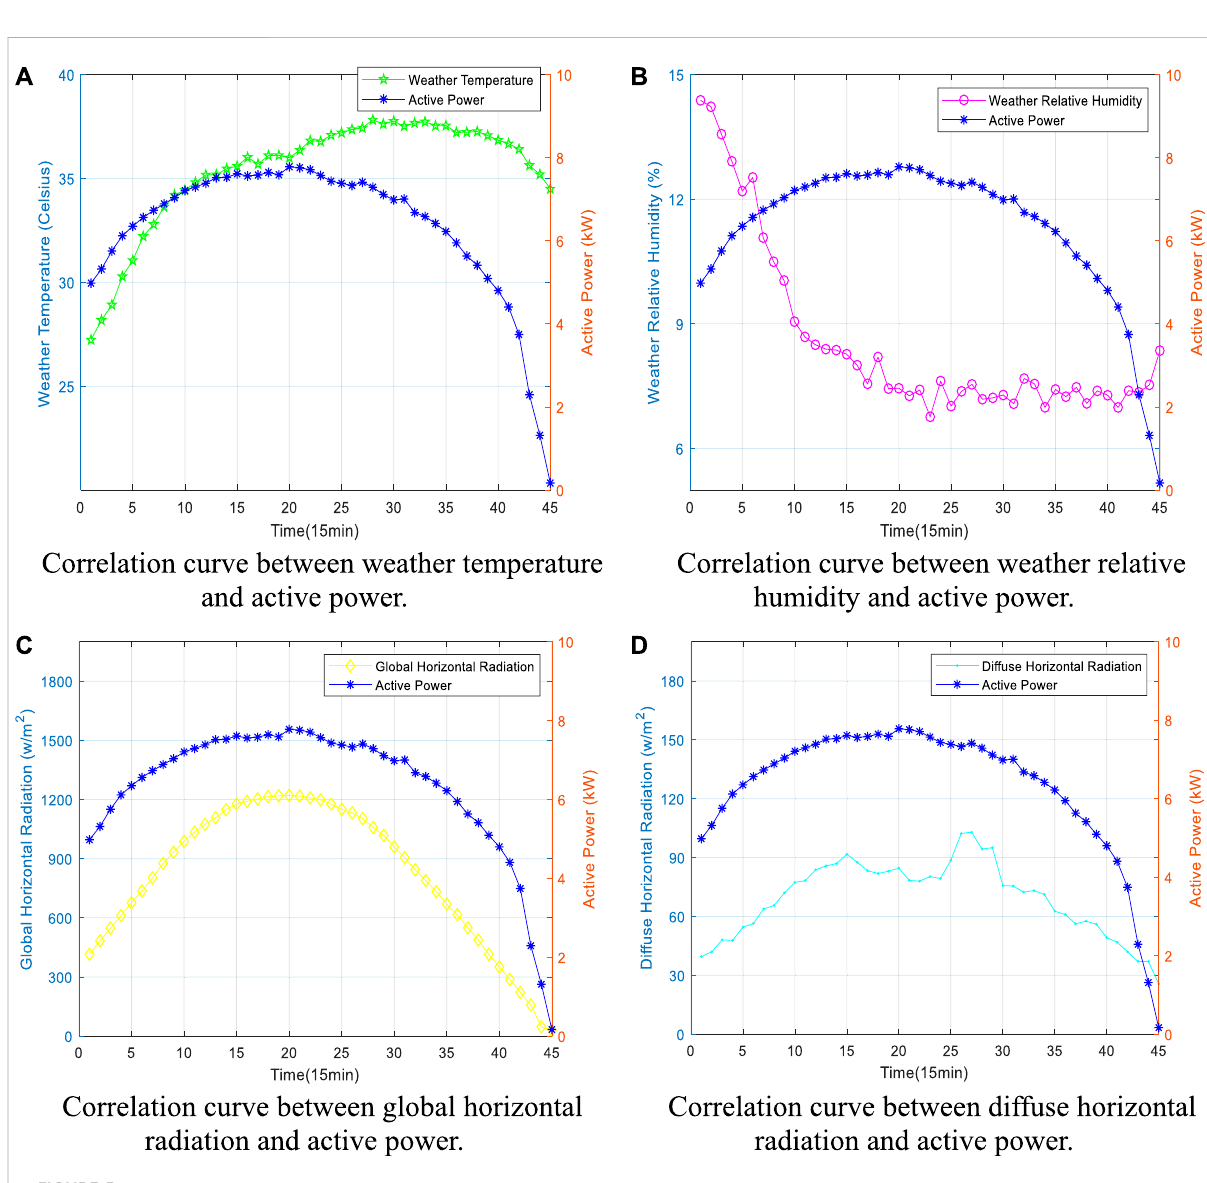
FIGURE 5 Correlation curve. (A) Between weather temperature and active power. (B) Between weather relative humidity and active power. (C) Between global horizontal radiation and active power; (D) Between diffuse horizontal radiation and active